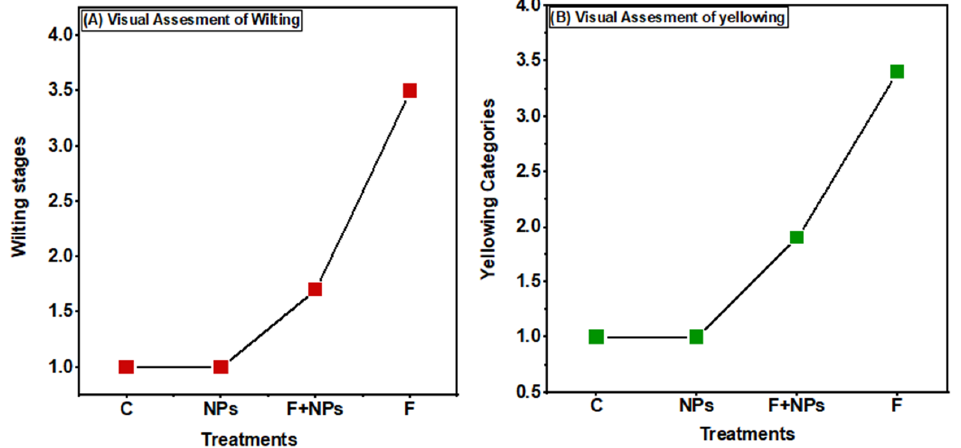
Figure 13. Visual assessment of wilting ( A ) and yellowing ( B ). C = control (without fungus and without priming), NPs = seeds primed with 0.5 µ g/mL NPs, F + NPs = seeds primed with 0.5 µ g/mL and sown in fungus-contaminated soil, F = seeds sown in fungus-contaminated soil.